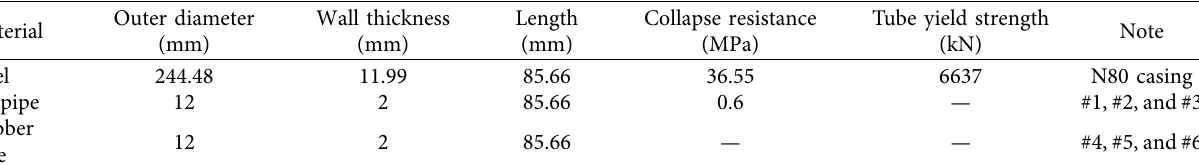
Figure 3: Surface well distribution (unit: cm). Table 1: Specifications of the surface wells.